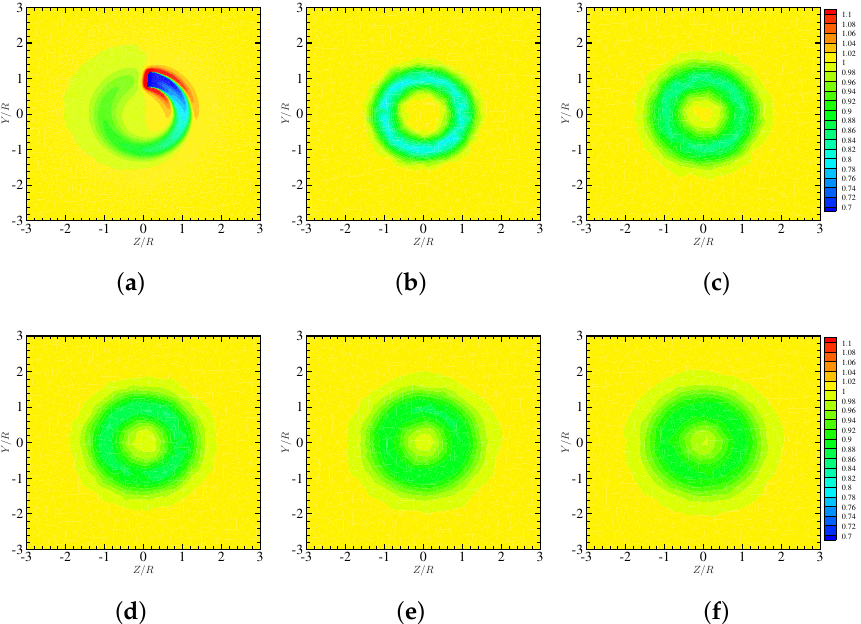
Figure 6. The distribution of the instantaneous, dimensionless axial flow velocity, U / U ∞ , in the YZ - plane at different axial distances from the plane of rotation: ( a ) X / R = 0, ( b ) X / R = 2, ( c ) X / R = 4, ( d ) X / R = 6, ( e ) X / R = 8, and ( f ) X / R = 10.